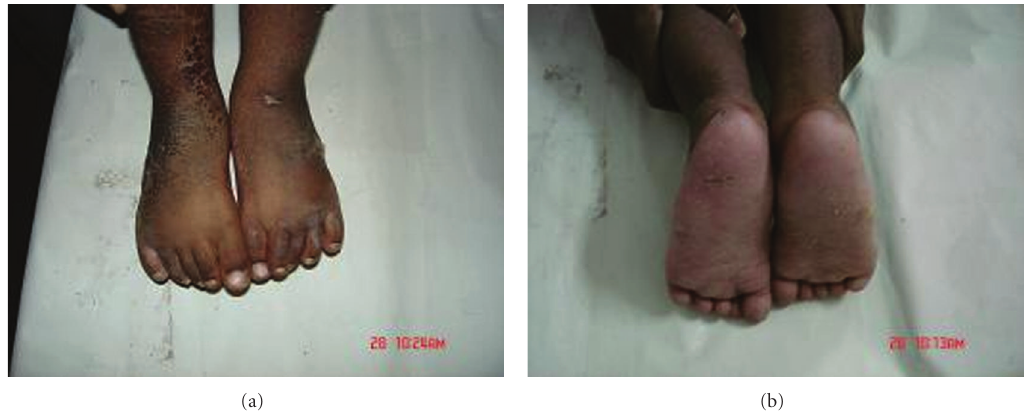
Figure 4: Clinical photos showing correction of deformities achieved by ligamentotaxis.